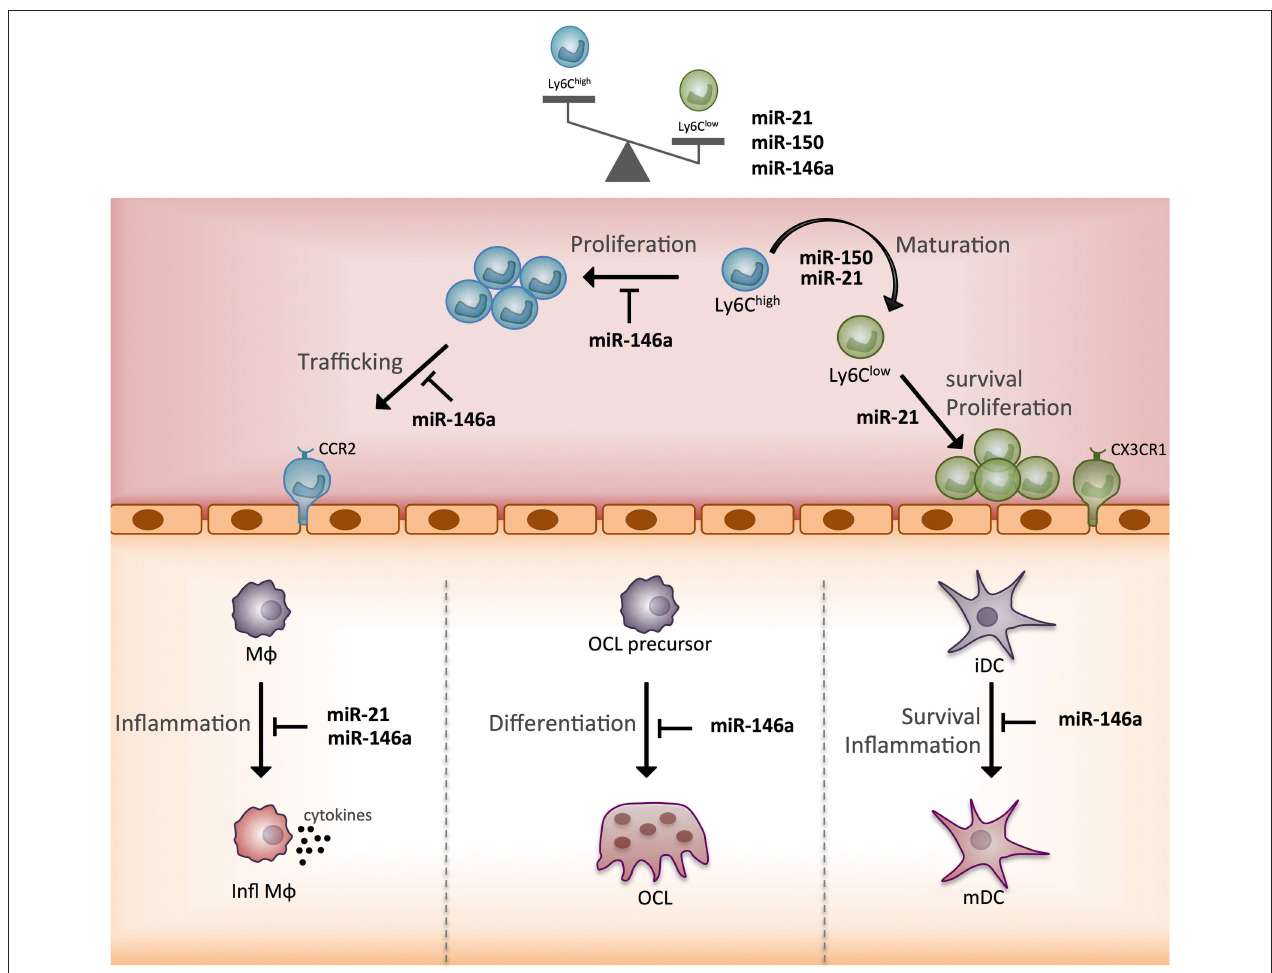
FIGURE 5 | Schematic representation of the function of three monocyte subset-specific miRNAs. With the three miRNAs showing differential expression in monocyte subsets that were functionally studied in mouse models, we propose a scheme outlining their role. M 8 , macrophage; Infl M 8 , inflammatory macrophage; OC, osteoclast; iDC, immature dendritic cell; mDC, mature dendritic cell; CCR2, C-C chemokine receptor type 2; CX3CR1, CX3C chemokine receptor